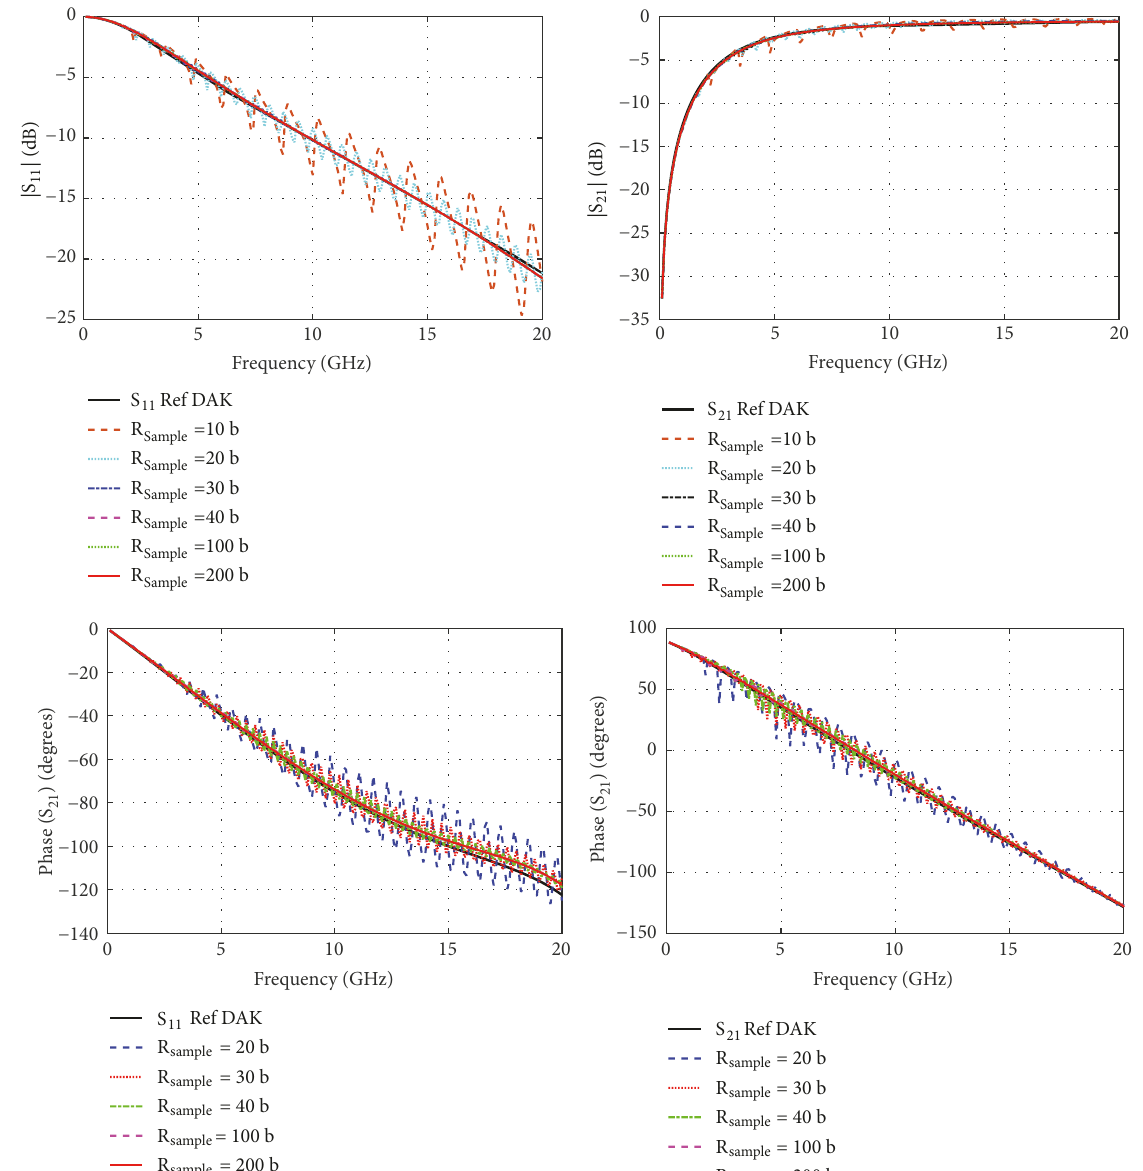
Figure 8: Magnitude (dB) and phase (degrees) of S 11 and S 21 for model A1 with TEM and TM 0 different values of the virtual circular waveguide containing the sample (thickness d =0.2